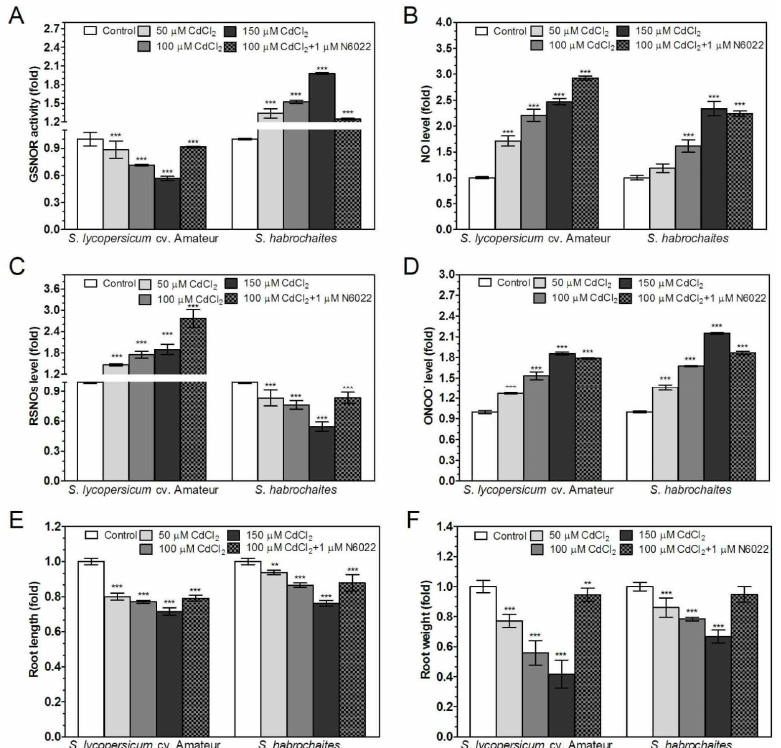
Figure 4. E ff ects of cadmium exposure on GSNOR activity, RNS levels and root growth in two Solanum spp. genotypes. Plants were grown in the growth medium containing 50, 100, 150 µ M CdCl 2 or combination of 100 µ M CdCl 2 with 1 µ M GSNOR inhibitor N6022. ( A ) GSNOR activity was evaluated spectrophotometrically at 25 ◦ C by monitoring the decrease of NADH absorbance at 340 nm. ( B ) Changes in NO levels in the root apical parts of were monitored by confocal microscopy using 20 µ M DAF-FM-DA. ( C ) The S-nitrosothiol content was determined by the modified Saville method. ( D ) Changes in ONOO − levels in the root apical parts of were monitored by confocal microscopy using 20 µ M APF. ( E , F ) The e ff ect of cadmium stress on plant growth was determined as ( E ) root lengths and ( F ) root fresh weights. As negative controls for NO and ONOO − determination, roots were pre-incubated with 200 µ M NO scavenger cPTIO or 20 µ M ONOO − scavenger ebselen,